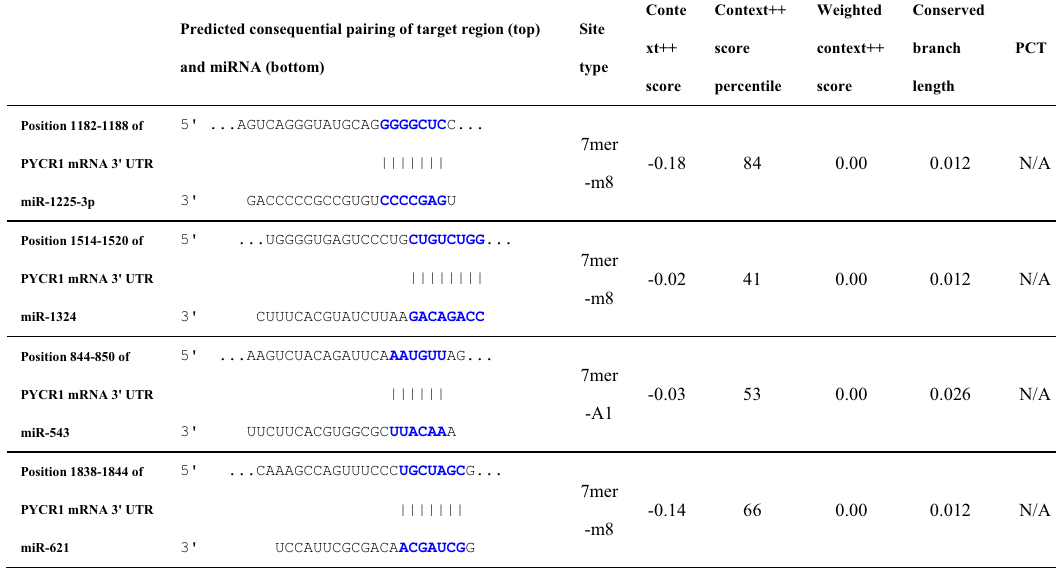
Table 4 Bioinformatics analysis of the binding between PYCR1 mRNA 3 ′ - UTR and the predicted miRNAs Predicted consequential pairing of target region (top) and miRNA